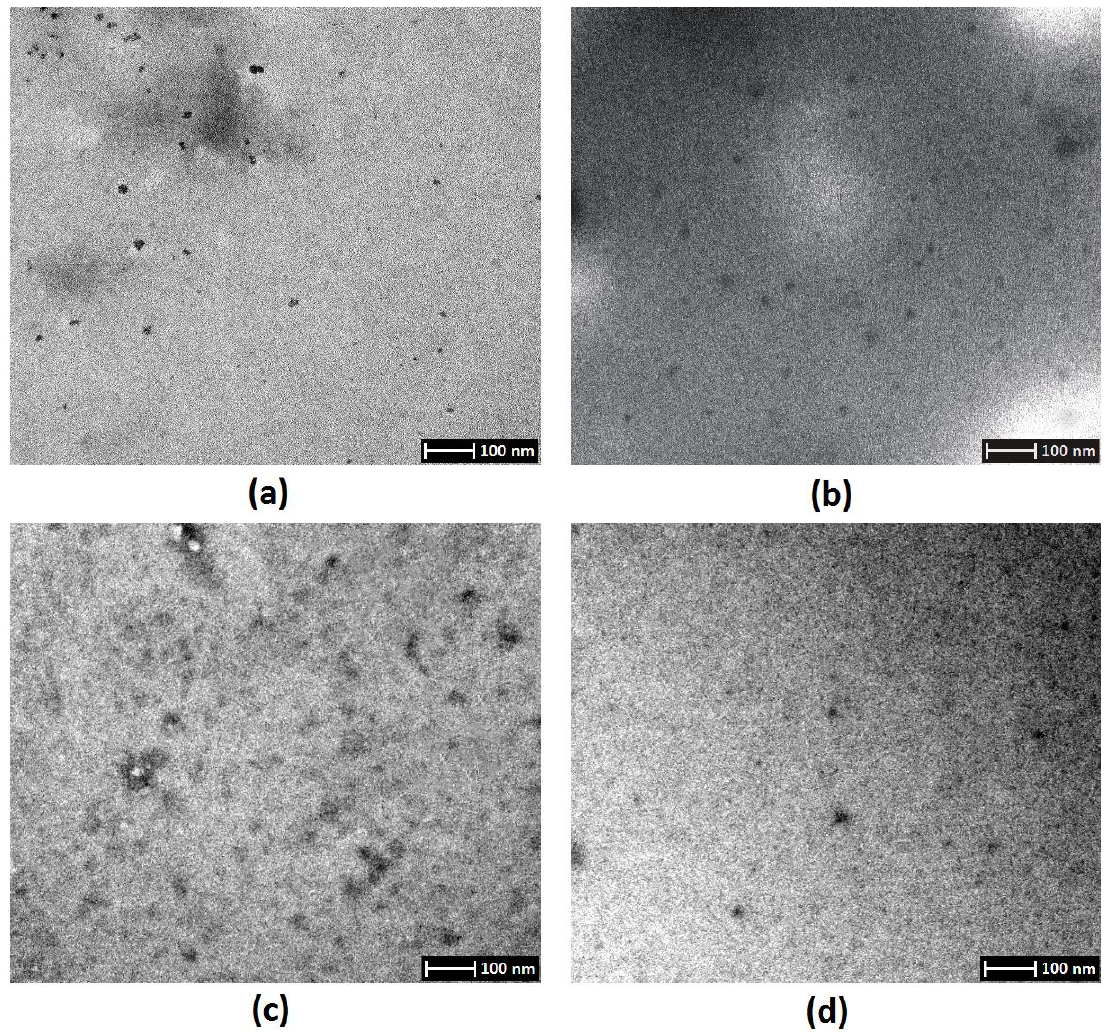
Figure 4 . TEM images ( a ) Dot-1 sample; ( b ) Dot-2 sample; ( c ) Dot-3 sample; ( d ) Dot-4 sample.